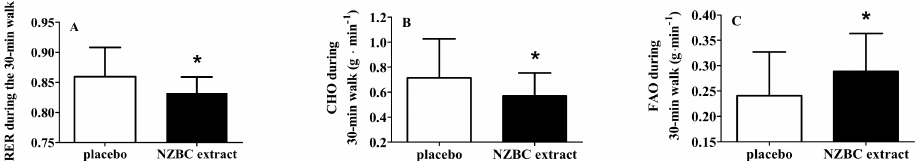
Figure 1. ( A ) Respiratory exchange ratio, ( B ) carbohydrate oxidation, and ( C ) fat oxidation during 30-min of moderate-intensity treadmill walking. Data are mean ± SD from 12 female participants. NZBC, New Zealand blackcurrant; RER, respiratory exchange ratio; CHO, carbohydrate oxidation; FAO, fat oxidation; *, indicates a difference with the placebo condition ( p <